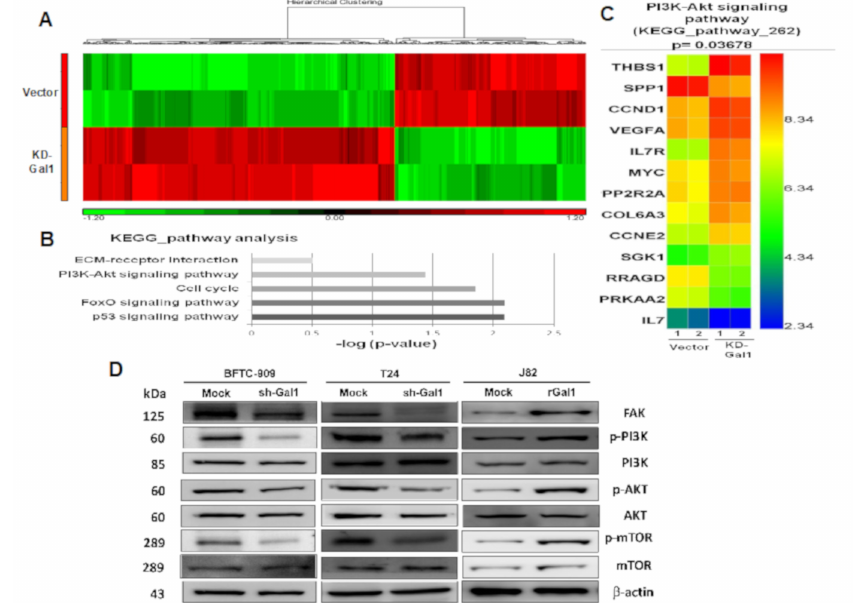
Figure 6. GAL1-mediated PI3K / AKT / mTOR pathway alteration assessed through microarray and Western blotting analyses: ( A ) A heatmap revealed upregulation and downregulation of genes with at least 2-fold di ff erence between the GAL1-vector and GAL1-KD cells. ( B ) Top five gene enrichment pathways in KEGG pathway analysis. ( C ) Heatmap of the 13 altered genes in the PI3K / AKT signaling pathway in the BFTC-909 cells (GAL-vector and GAL1-KD). ( D ) Western blotting of GAL1 knockdown or overexpression in the FAK / PI3K / AKT / mTOR signaling pathways in the BFTC-909, T24, and J82 cells. Mock: Cells were treated with DMSO vehicle only. β -Actin was used as the protein-loading